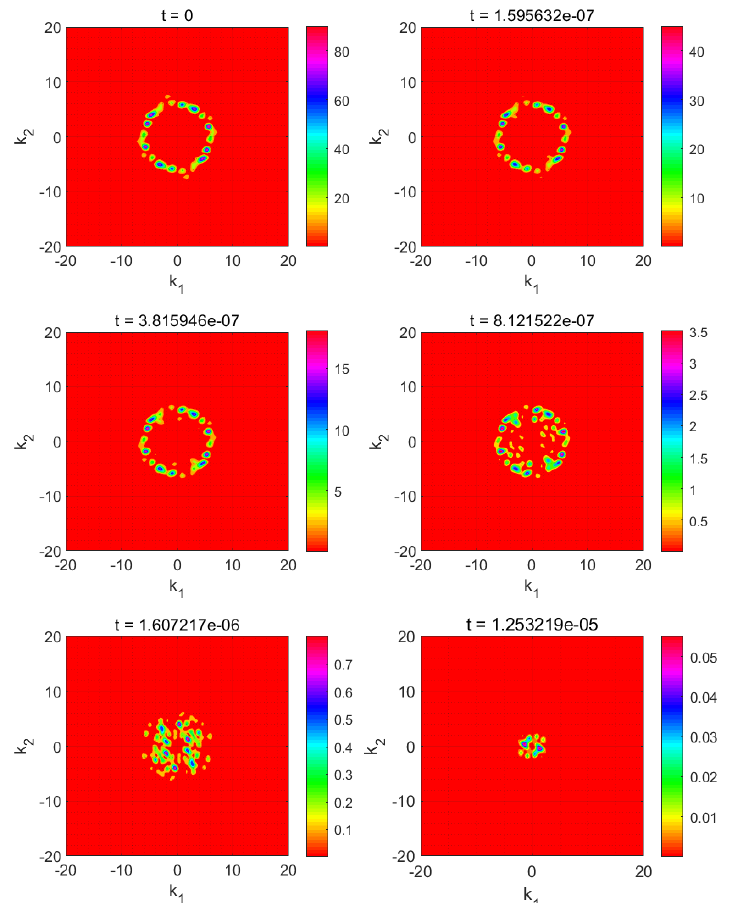
Figure 13. Simulated light-scattering patterns obtained from the calculated structure factors for the case where D = 10 5 , c o* = 0.3 and T * = 036. The asterisks were left out of the variables k 1 , k 2 , and t in the figure.